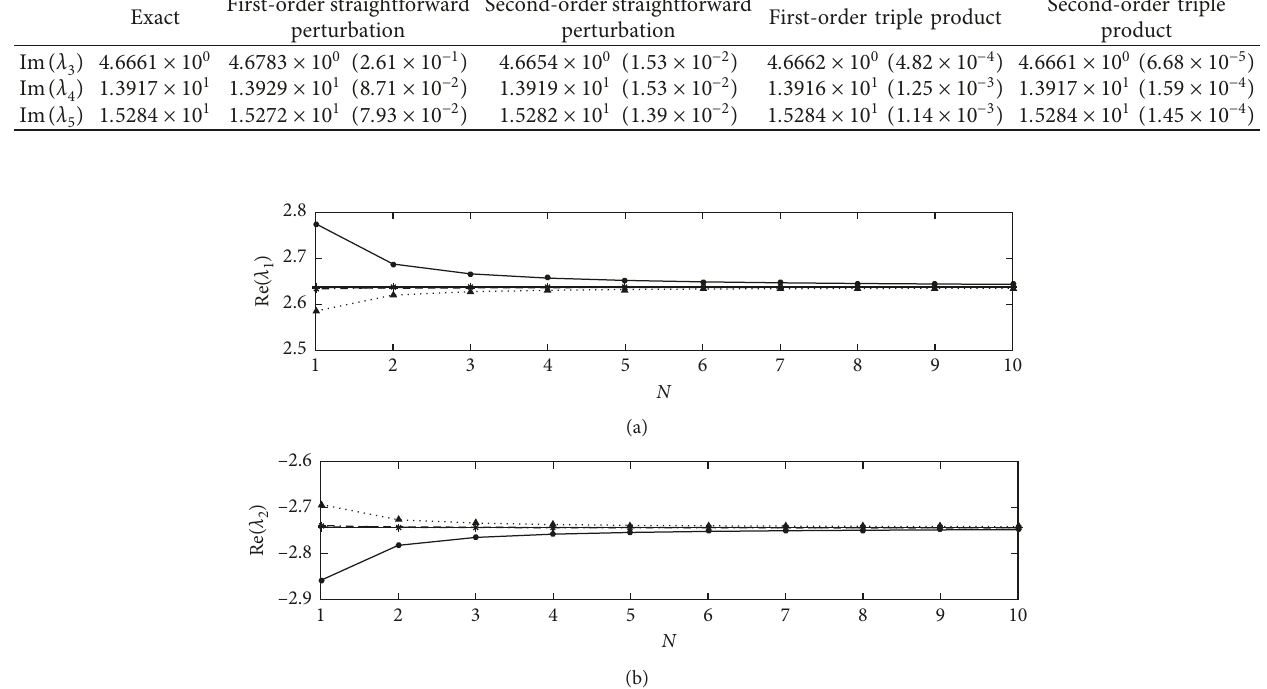
Table 8: The imaginary parts of the exact and approximate natural frequencies for the perturbed whirling beam of Figure 11 for σ Exact